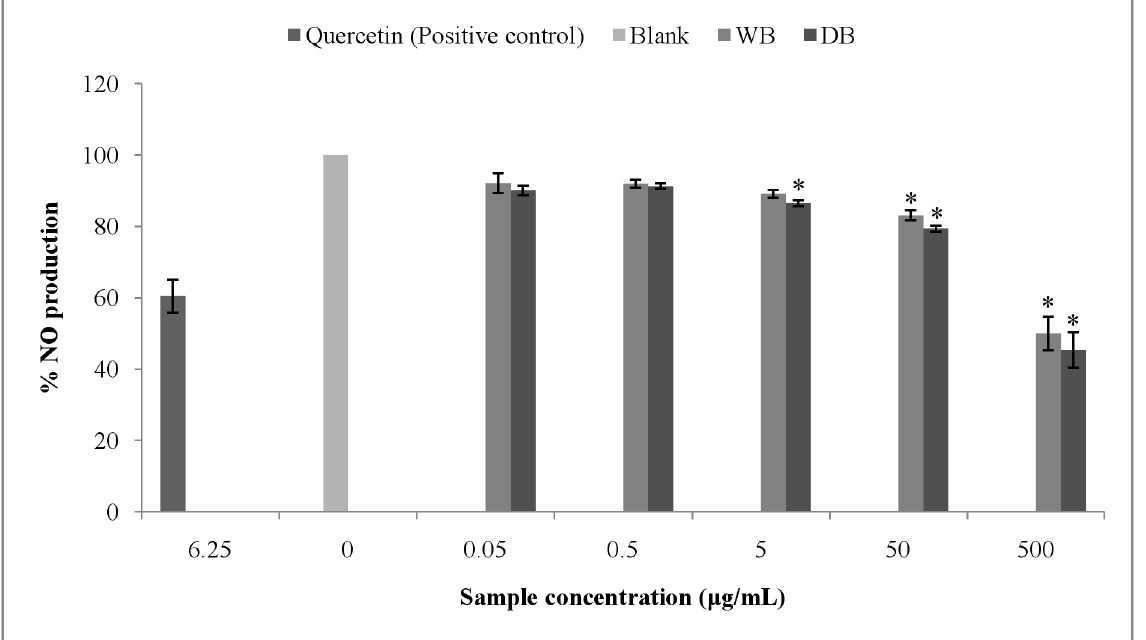
Fig 6. Effects of A . rugosum extracts on NO production by sodium nitroprusside (SNP) (S1 Dataset). A . rugosum extracts were co-incubated with SNP (5mM dissolved in PBS) solution for 90 minutes. Quercetin (6.25 μ g/mL) was used as the positive control. Results shown represent the mean ± SEM, n = 3 and * p < 0.05 versus SNP-induced NO